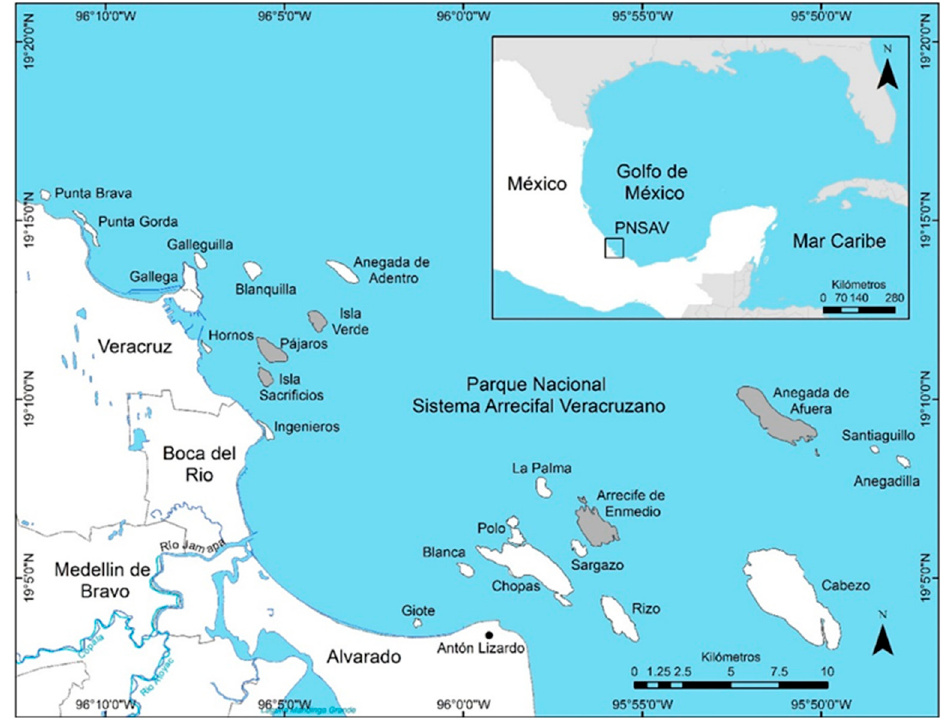
Figure 1. Geographical location of the Veracruz Reef System National Park. Sampling areas are shaded.